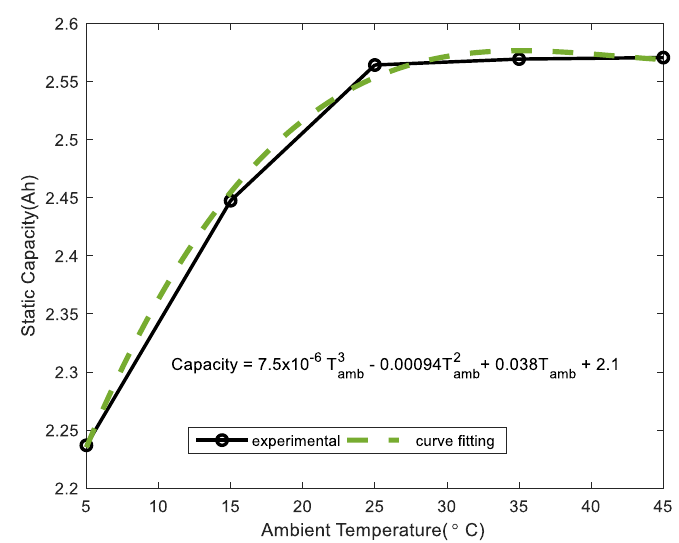
Figure 2. Cell capacity of battery cell as function of ambient temperature.